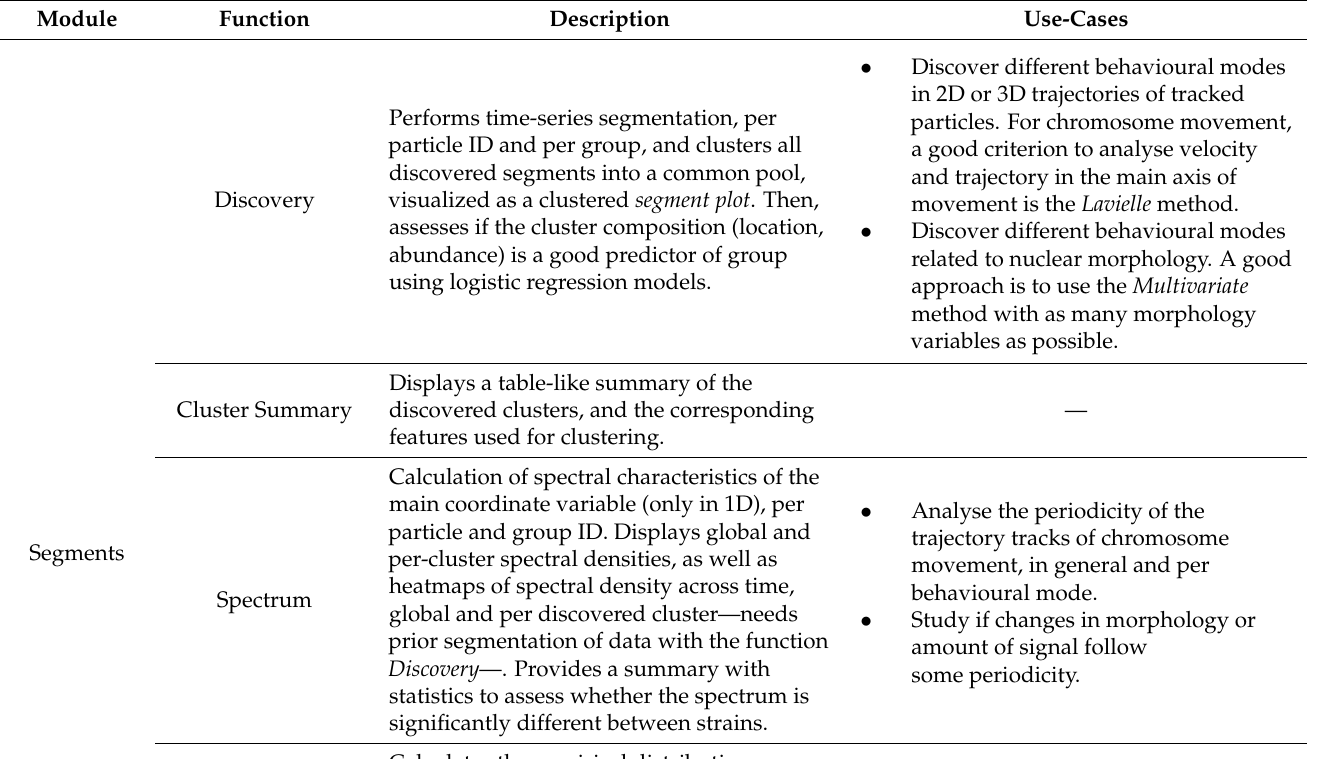
Table 1. Description of ChroMo analysis modules, functions, and their general use